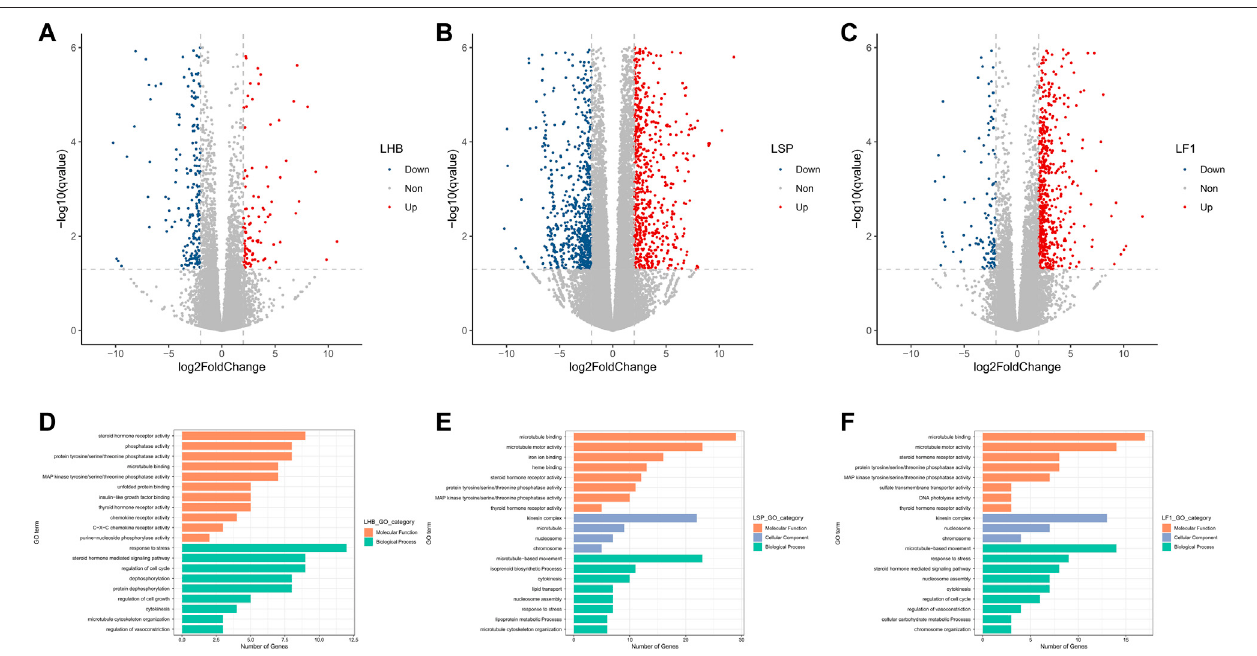
FIGURE 3 | Volcano plot of log2 fold change and -log10 (FDR) of the differentially regulated genes demonstrated that most of the genes were up-regulated in all three strains of carp liver. (A) Volcano plot for Hebao red carp liver DEGs (LHBN1, LHBN2, LHBN3, LHBN5, LHBN6, LHBH1, LHBH2, LHBH3, LHBH4, LHBH5). (B) Volcano plotfor Songpumirrorcarp liverDEGs (LSPN1, LSPN3, LSPN4, LSPN5, LSPN6, LSPH1, LSPH2, LSPH3, LSPH5, LSPH6). (C) Volcano plotfor hybrid F1carp liver DEGs (LF1N1, LF1N2, LF1N3, LF1N4, LF1N5, LF1H1, LF1H3, LF1H4, LF1H5, LF1H6). GO enrichment analysis for genes differentially expressed between normoxiaandhypoxiagroups. (D) .Signi fi cantlyenriched GOtermsareshownforhypoxia-stressedHebaoredcarpliver. (E) .Signi fi cantlyenriched GOtermsareshown for hypoxia-stressed Songpu mirror carp liver. (F) . Signi fi cantly enriched GO terms are shown for hypoxia-stressed hybrid F1 carp